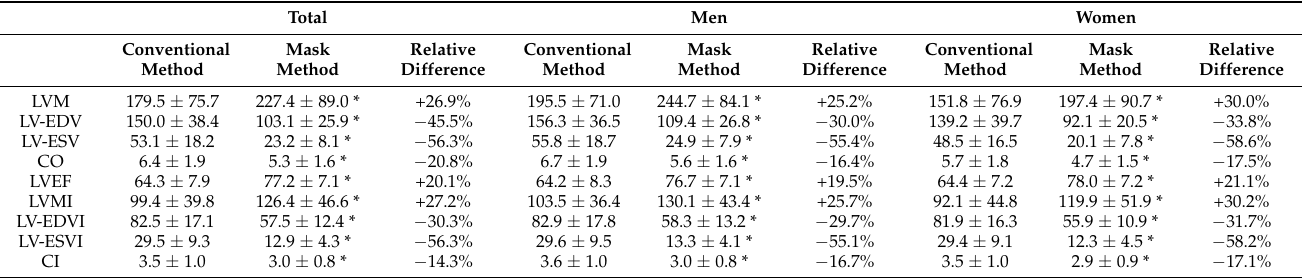
Table 2. CMRI findings according to two methods of analysis in patients with hypertrophic obstruc- tive cardiomyopathy.